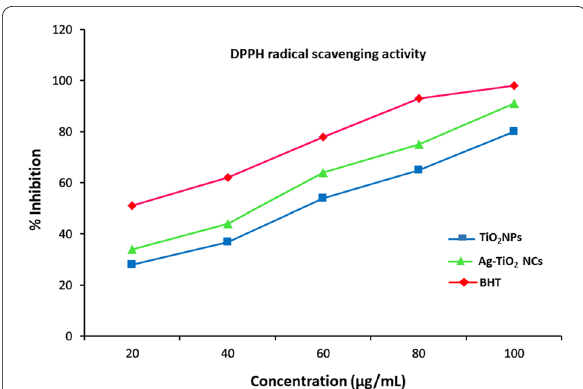
Fig. 8 DPPH assay showing enhanced antioxidant activity of green-synthesised Ag–TiO 2 NCs at different